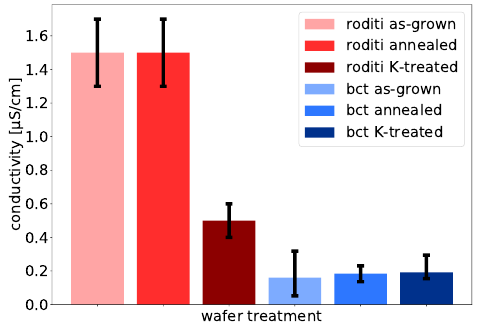
Figure 2. Comparison of ionic conductivities in different KTP wafers for as-grown, annealed and K-treated